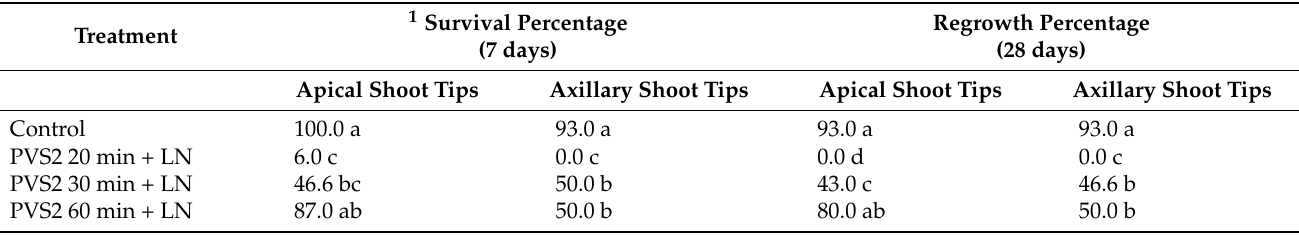
1 Statistical analysis in each column was performed by ANOVA. Data followed by different letters are significantly different at p ≤ 0.05 by Bonferroni’s